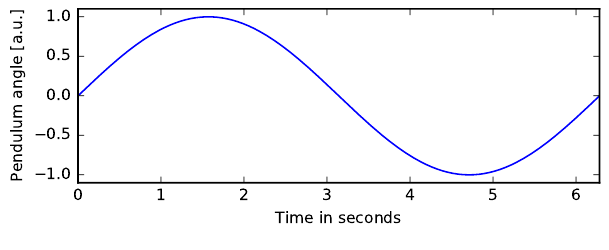
Fig. 88.— Simple Hubble plot